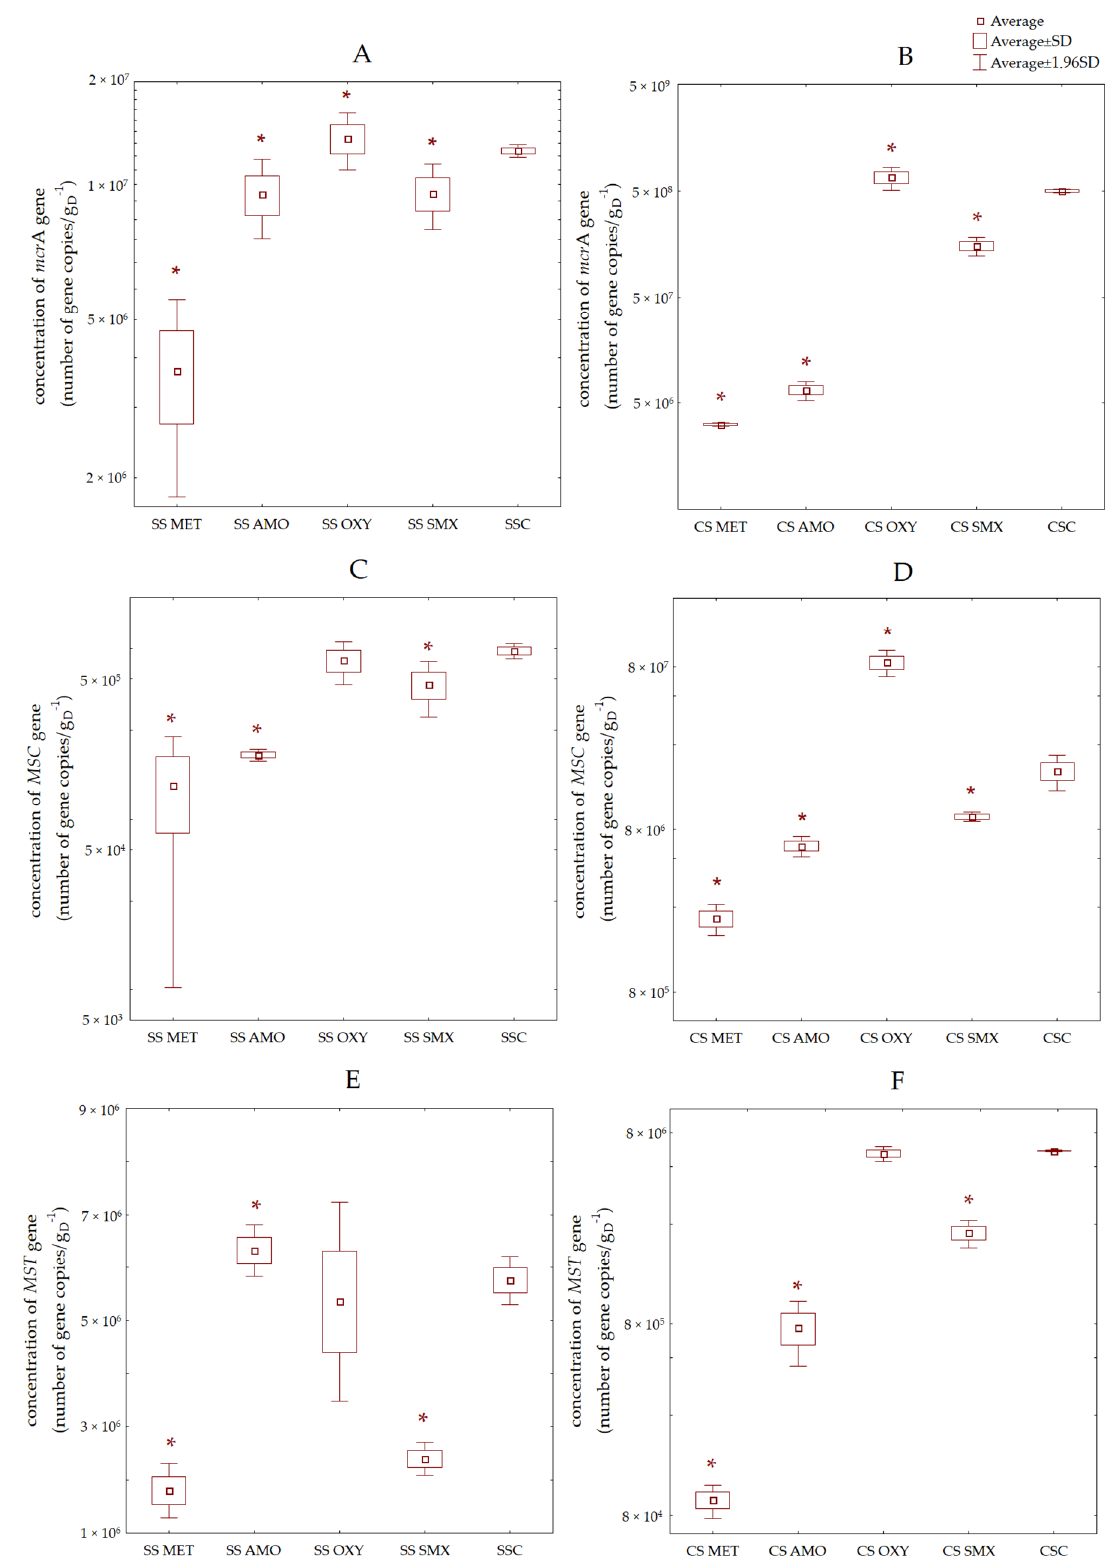
Figure 2. Average concentrations of mcr A, MSC and MST genes in 1 g D − 1 of sewage sludge samples ( A , C , E , respectively) from the process and control bioreactors and cattle slurry samples ( B , D , F , respectively) from the process and control bioreactors. (SSC) control samples of sewage sludge, (CSC) control samples of cattle slurry, (*) indicates statistically significant differences compared to the proper control ( p < 0.05).